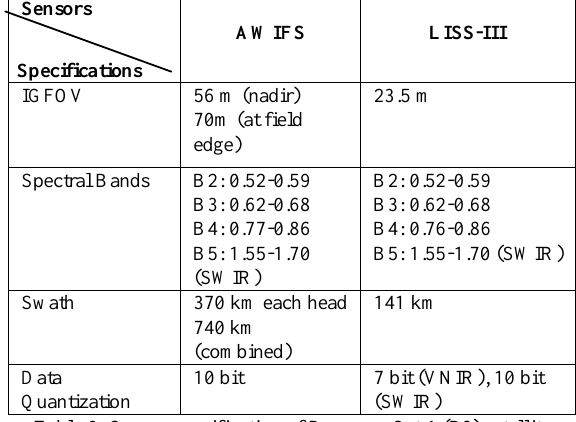
Table 3: Sensor specification of Resource Sat-1 (P6) satellite